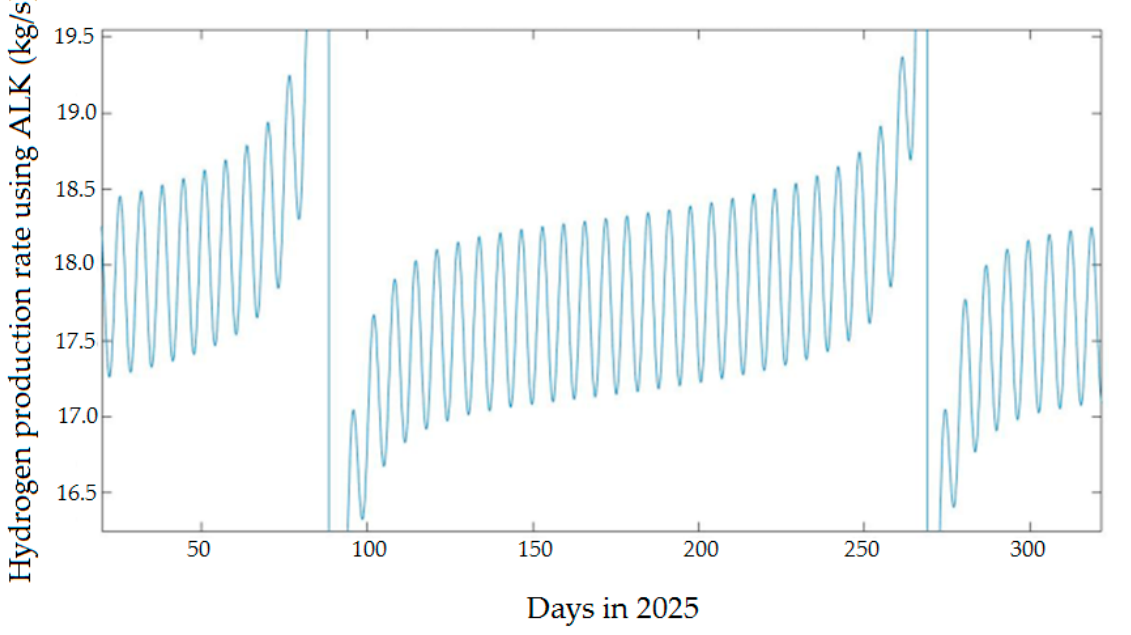
Figure 9. Hydrogen production rate applying ALK during 2025.